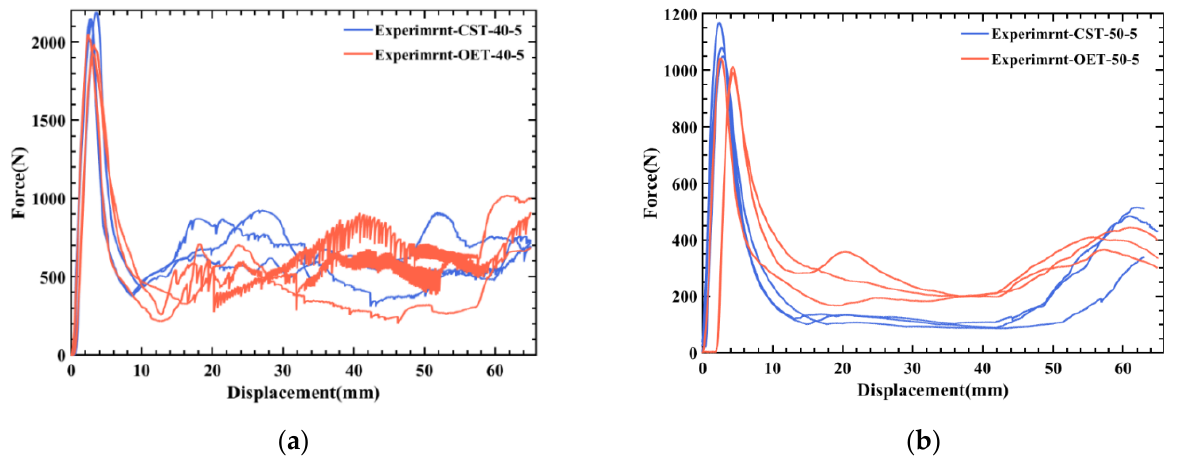
Figure 13. The compression rate at 5 mm/min: comparison of force–displacement curves of CST and OET: ( a ) 40 °C; ( b ) 50 °C.